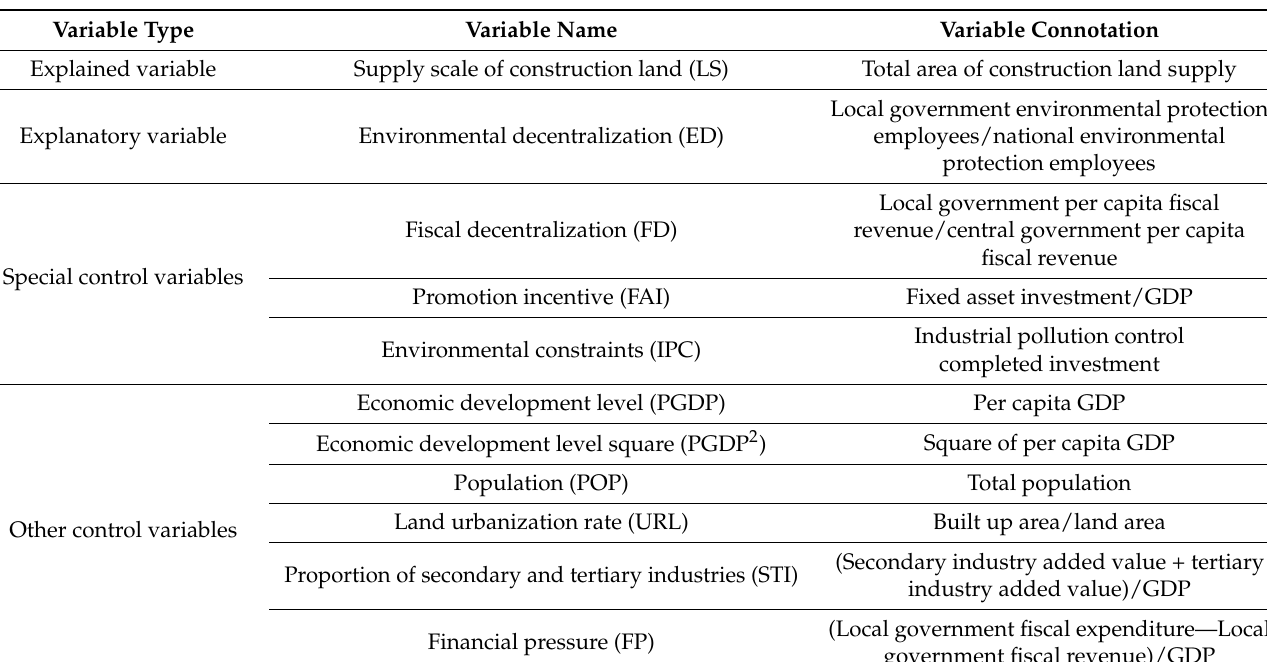
Table 1. Variable